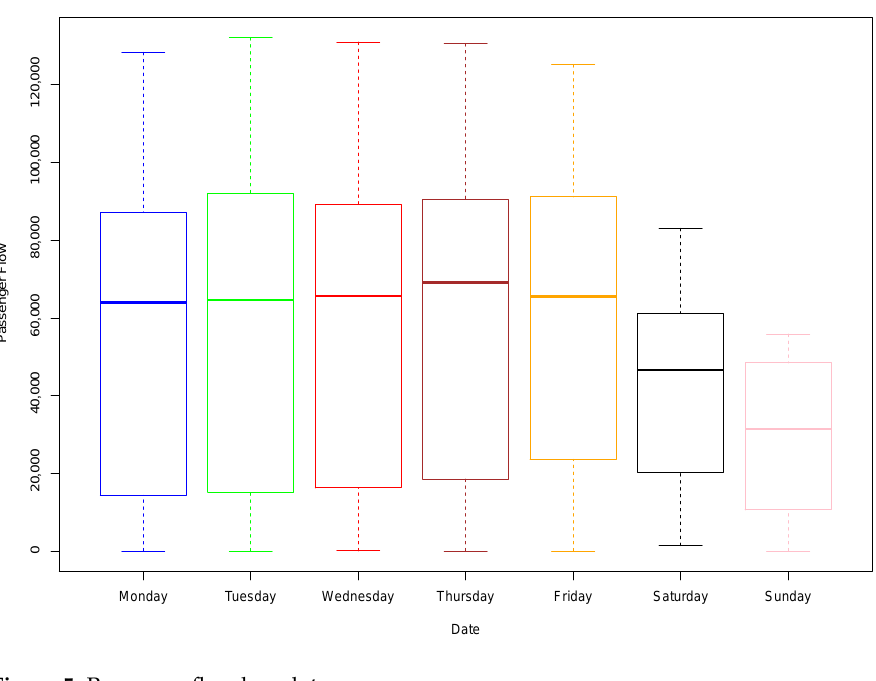
Figure 5. Passenger flow